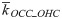
Elastic reactance experienced by the outer hair cell.
k¯OCC_OHC and k¯OCC_HB were obtained by simulating the OCC deformation by reactive forces due to somatic motility and hair bundle motility. See text for the definition. (A) Deformation pattern of the OCC at x = 10 mm when a coupled axial force (f
B) was applied to the outer hair cell. The corresponding displacement (δ
OHC) represents the compliance of the OCC experienced by the outer hair cell. (B) Deformation pattern of the OCC at x = 10 mm when a coupled shear force (f
A) was applied to the outer hair cell hair bundle. (C) In the conventional model of the OCC, the elastic reactance to the outer hair cell is determined by three components (k
TM/RL, k
OC, and k
BM) that vary exponentially along the distance. (D) k¯OCC_OHC and k¯OCC_HB along the distance. (E) Change of k¯OCC_OHC due to the stiffness change of the BM, the TM and the Deiters cell. (F) Change of k¯OCC_HB due to the stiffness change of the BM, the TM and the Deiters cell. (E) and (F) results were obtained at x = 6 mm.